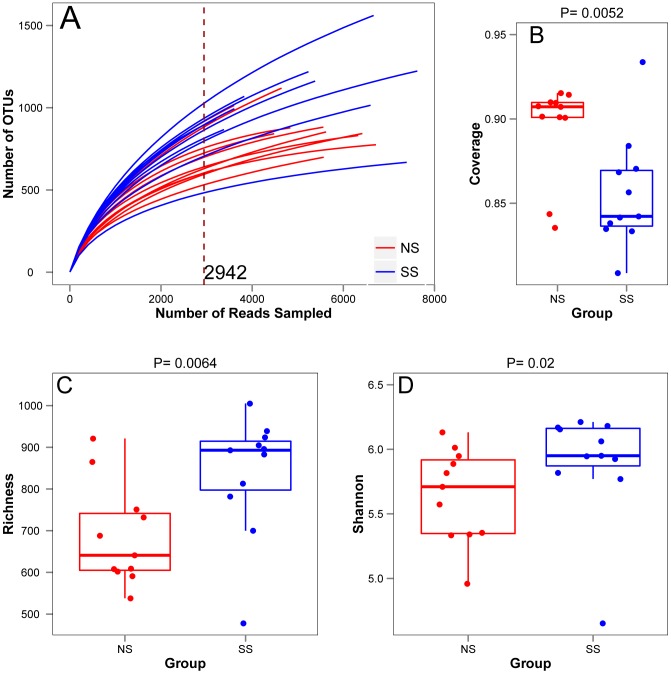
Alpha diversity in cattle fecal samples from super-shedder (SS) and non-shedder steers (NS) as represented by rarefaction curves (A), and boxplots for Good's coverage (B), Richness (C) and Shannon Diversity Index (D) using the Esprit-tree OTU matrix.The number of OTUs was used as a measure of the richness in Fig C. In Fig B, C and D, each box plot summarizes the distribution of the data set. Lower, mid, and upper horizontal lines denote the first quartile, median and the third quartile, respectively. Vertical lines reach the 1.5 interquartile range from the respective quartiles or reach the extreme value, whichever is closer. The remaining clustering methods gave similar results.